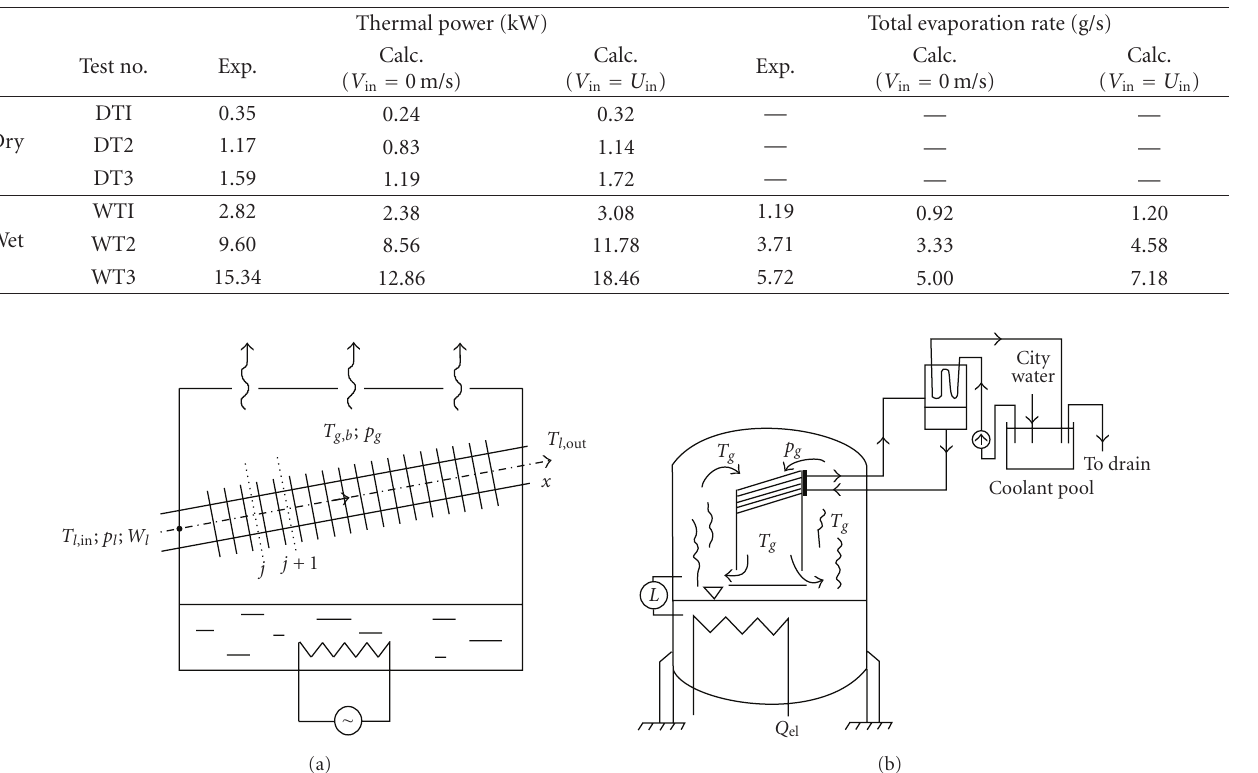
Table 2: Results obtained by the FLUENT calculations for the dry and wet EFFE tests [15].